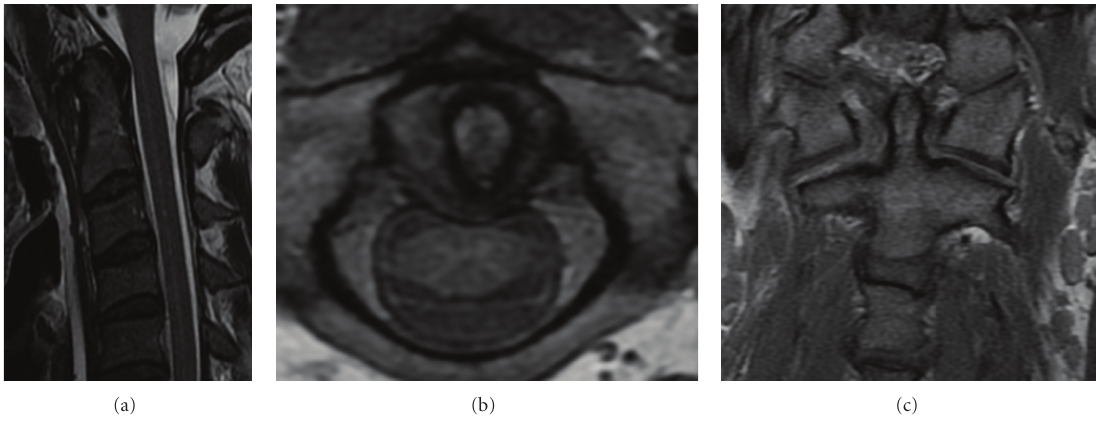
Figure 2: Cervical magnetic resonance imaging showing injury of ligament: midsagittal (a), axial (b), and coronal (c)